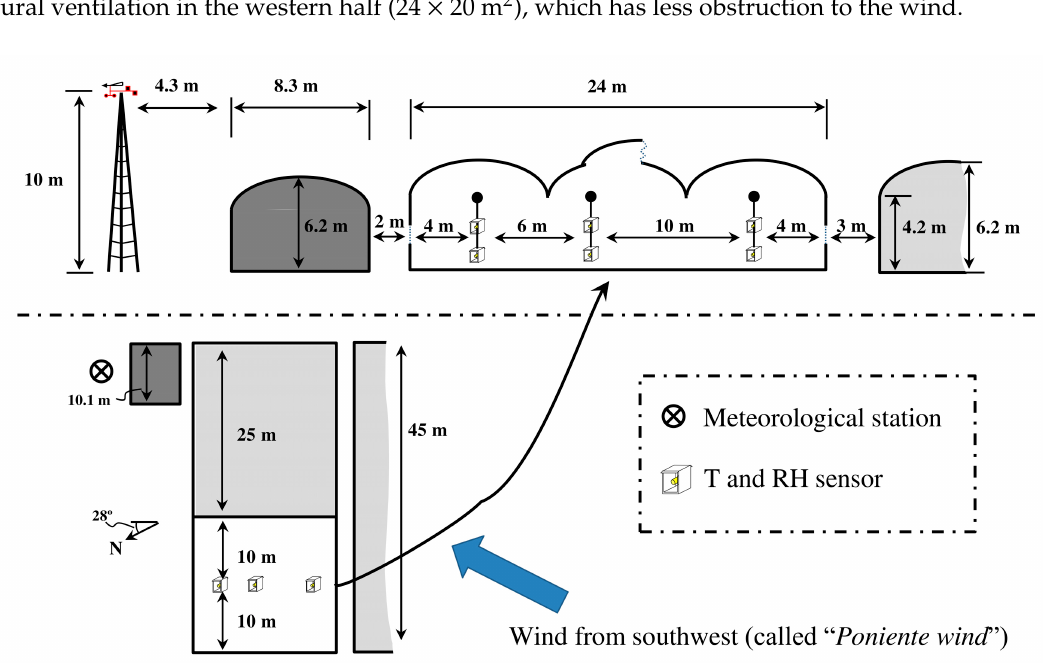
Figure 1. Location of the experimental greenhouse at the farm.